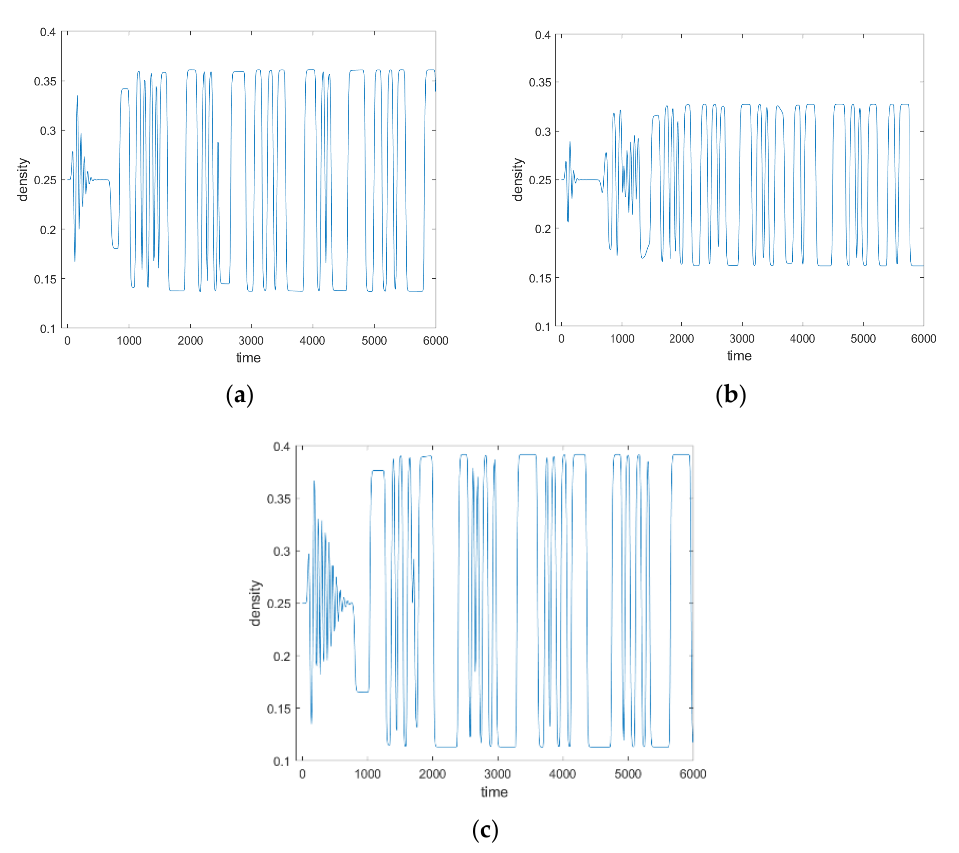
Figure 7. Traffic wave sketch of lattice j = 45 for variable delay and constant delay, in which ( a ) d ( k ) = round ( 3 + 2sin ( k )) , ( b ) d ( k ) = 1 and ( c ) d ( k ) =